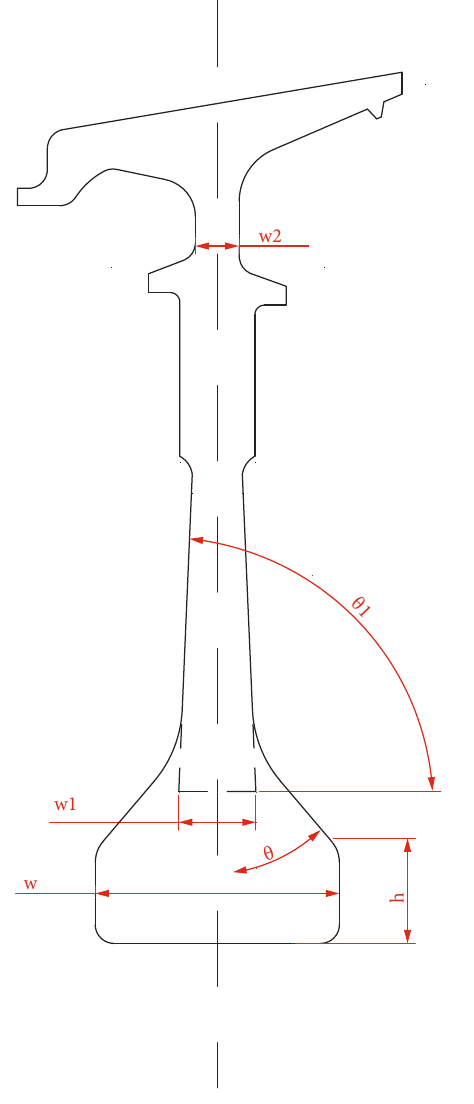
Figure 2: Design